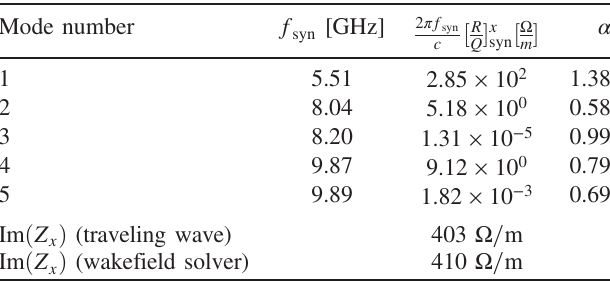
TABLE II. Transverse traveling wave data for one period of the bellows structure depicted in Fig. 3. The final result for Im ð Z the sum of the elements of the third column weighted with the corresponding factors α . The result of the wakefield solver is also shown for comparison.